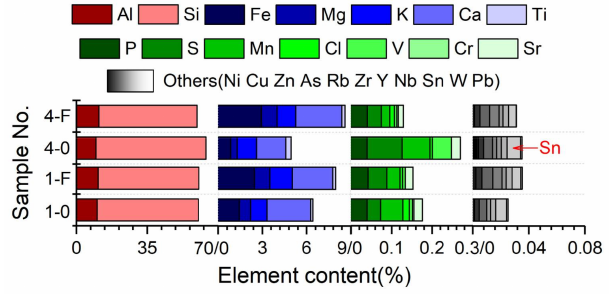
Figure 3. Element content of Pisha